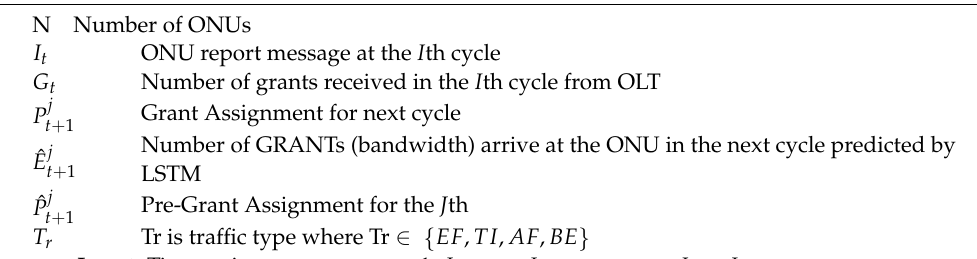
Algorithm 1: LSTM